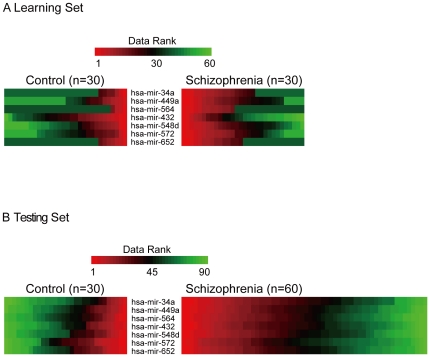
A comparison of: (A) the TLDA-based miRNA expression levels between the schizophrenia patients (n = 30) and the controls (n = 30) for the seven miRNAs; and (B) quantitative RT-PCR-based miRNA expression levels between the schizophrenia patients (n = 60) and the controls (n = 30) for the same seven miRNAs.The red, black, and green hues denote relatively high, intermediate, and low expression levels. To emphasize the rank-sum property of the Wilcoxon test, all the expression levels of miRNA were converted to relative expression ranks within each miRNA. Ranks for each miRNA were sorted separately for the control group and disease group before they were placed side-by-side for easier comparison between the two groups and across all putatively informative miRNAs.